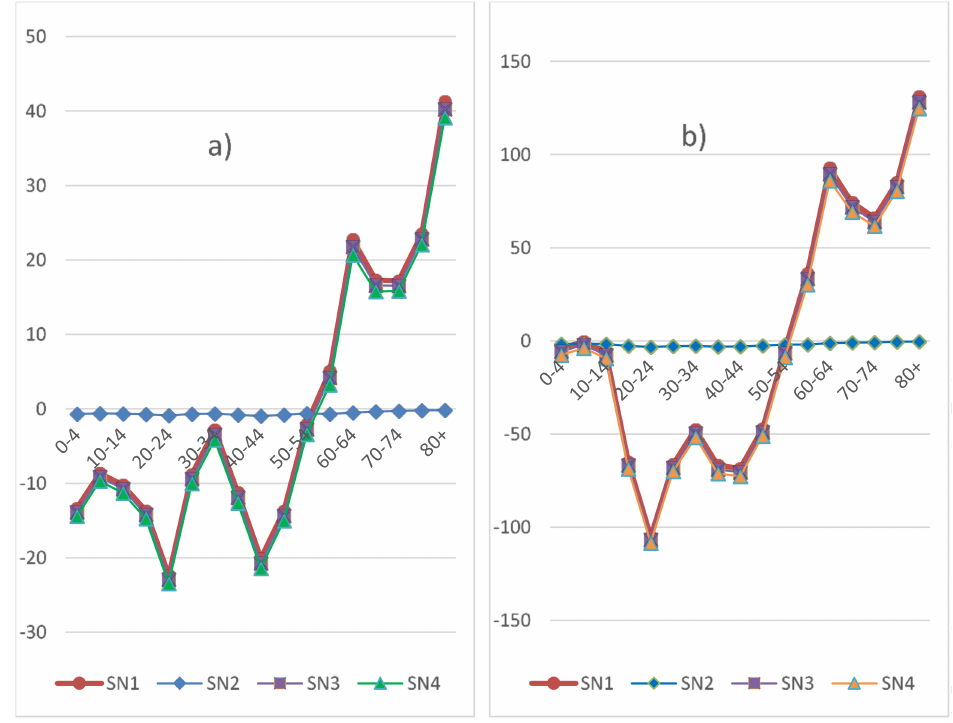
Figure 2. Consumption by age group, deviations from BAU for rural households ( a ) and urban households ( b ). Billion USD2011. Sources: The